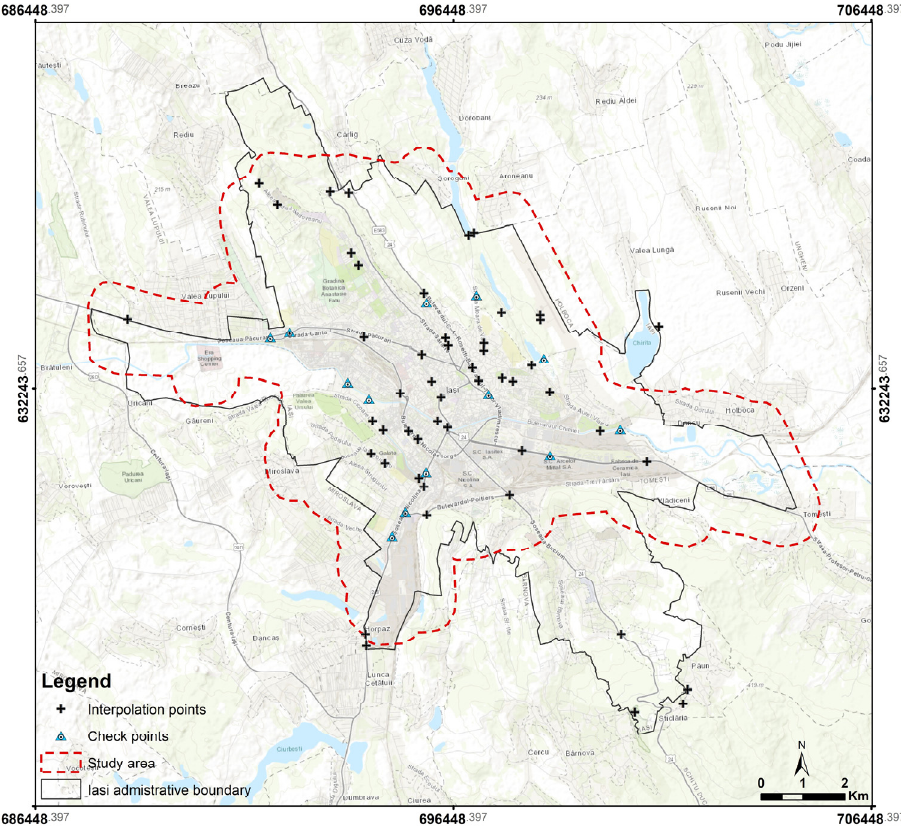
Figure 14. Distribution of the 50 interpolation points and the 13 check points in Iasi city area.